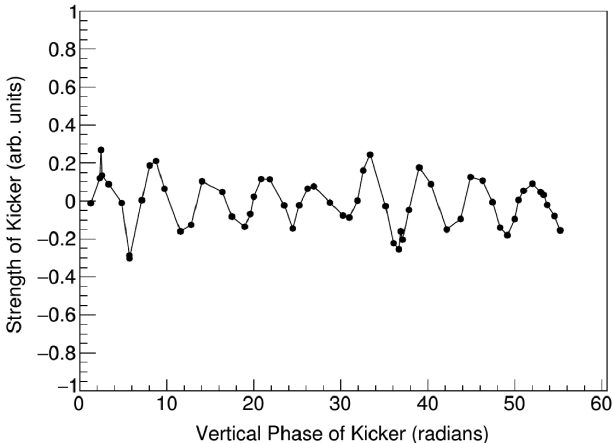
FIG. 2. The relative strengths of the kickers used in the first eigenvector as a function of their vertical betatron phase in CESR. Their arrangement in the shape of a betatron wave is readily apparent. The vertical tune is 8.79, nearly matching the 9 crests of the